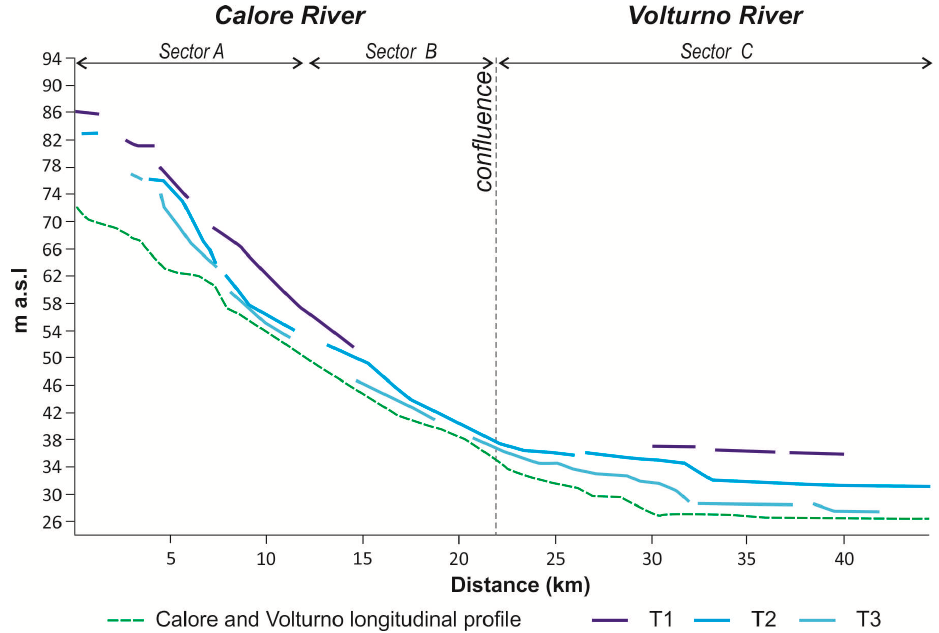
Figure 6. Calore and Volturno rivers longitudinal profiles and reconstruction of valley floor terraces T1–T3.